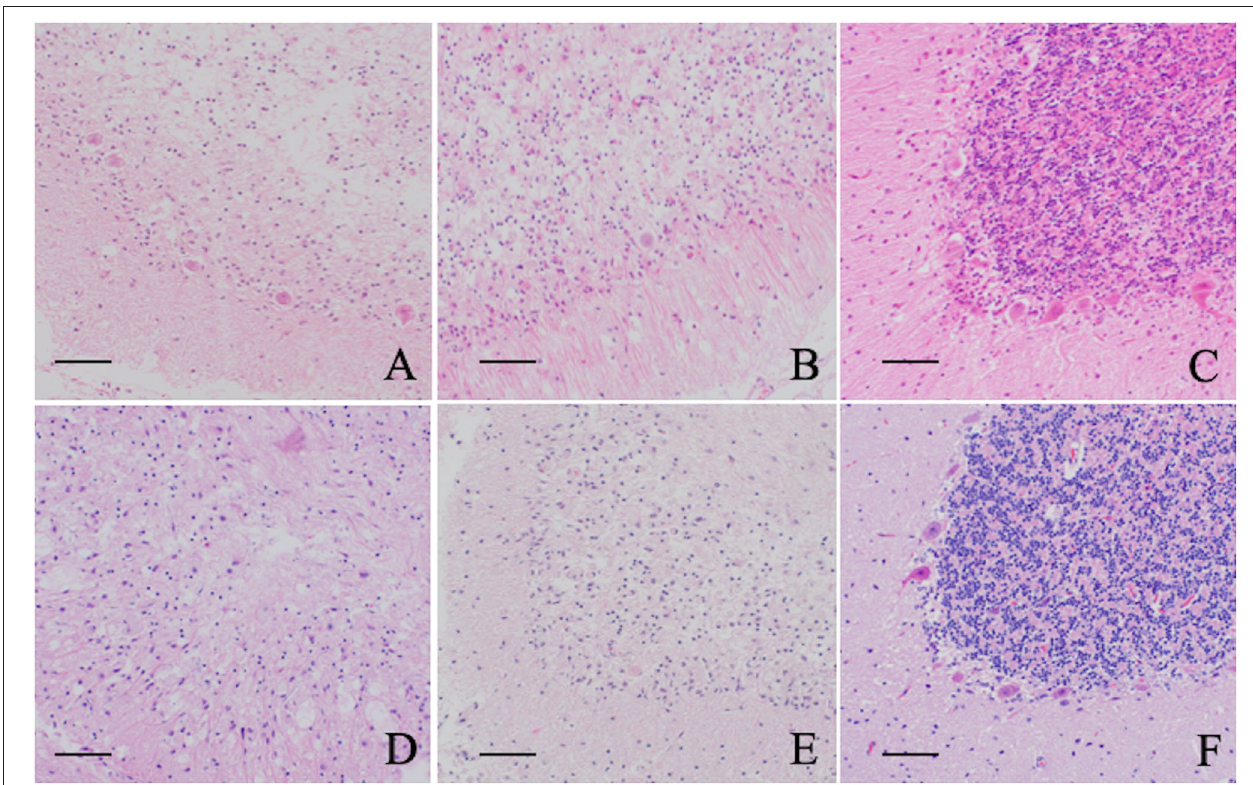
FIGURE 4 | Histopathological features of the cerebellar nodulus and ventral uvula of five lysosomal storage diseases. (A) Chihuahuas with NCL (Case 1), (B) Border Collie with NCL (Case 3), (C) Shikoku Inu with NCL (Case 5), (D) Toy Poodle with GM2 gangliosidosis variant 0 (Sandhoff disease) (Case 7), (E) Shiba Inus with GM1 gangliosidosis (Case 8), F: normal control dog. Neuronal degeneration and loss are mildly observed in a Shikoku Inu with NCL and severely in other cases compared to a control dog. All sections are HE stained. Bar = 50 µ